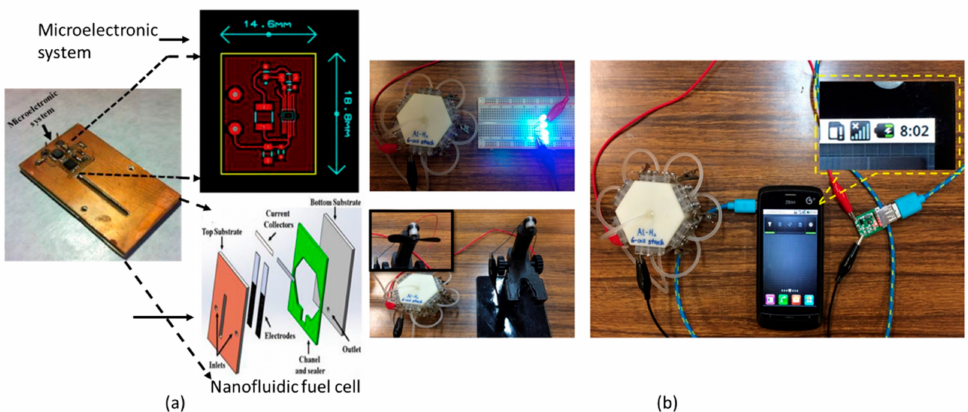
Figure 15. Applications of MMFCs: ( a ) membraneless nanofluidic fuel cell assembly with microelec- tronic system for low-power applications (reprinted from ref. [189]. Copyright 2016 Elsevier) and ( b ) an aluminum feed MMFC stack demonstrated for several practical applications (reprinted from ref. [149]. Copyright 2016